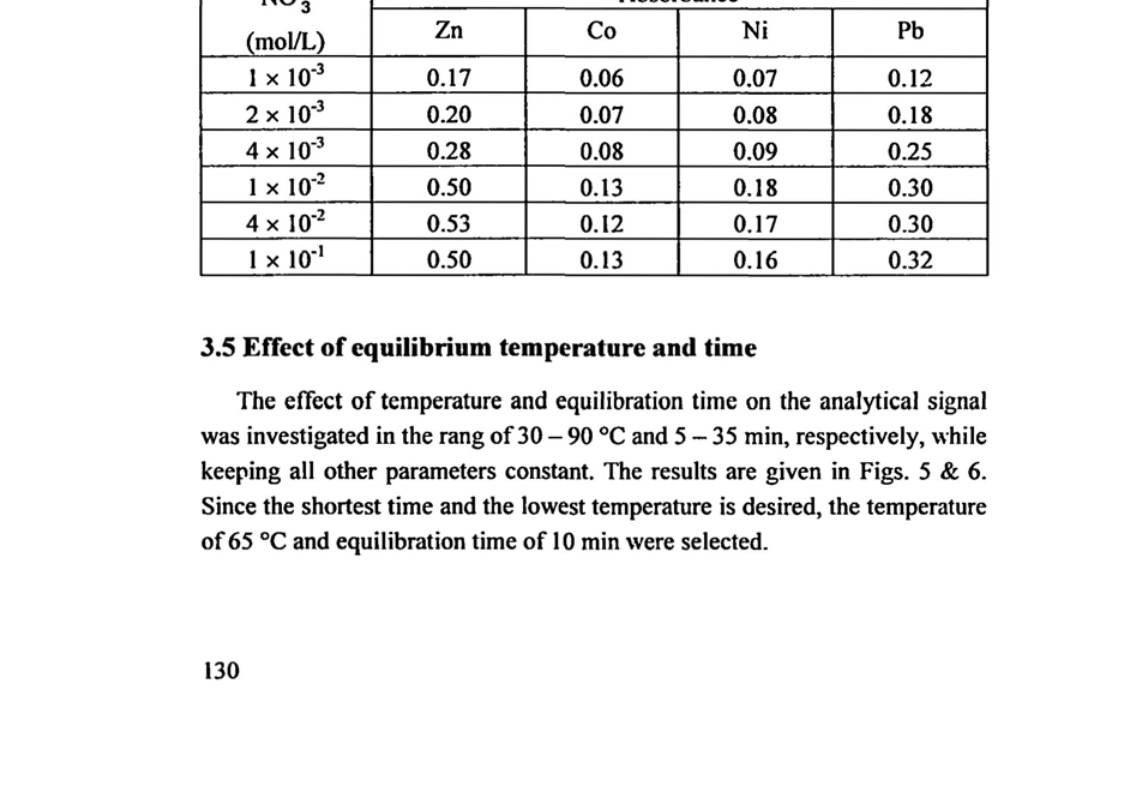
Fig. 4: Effect of equilibrium temperature